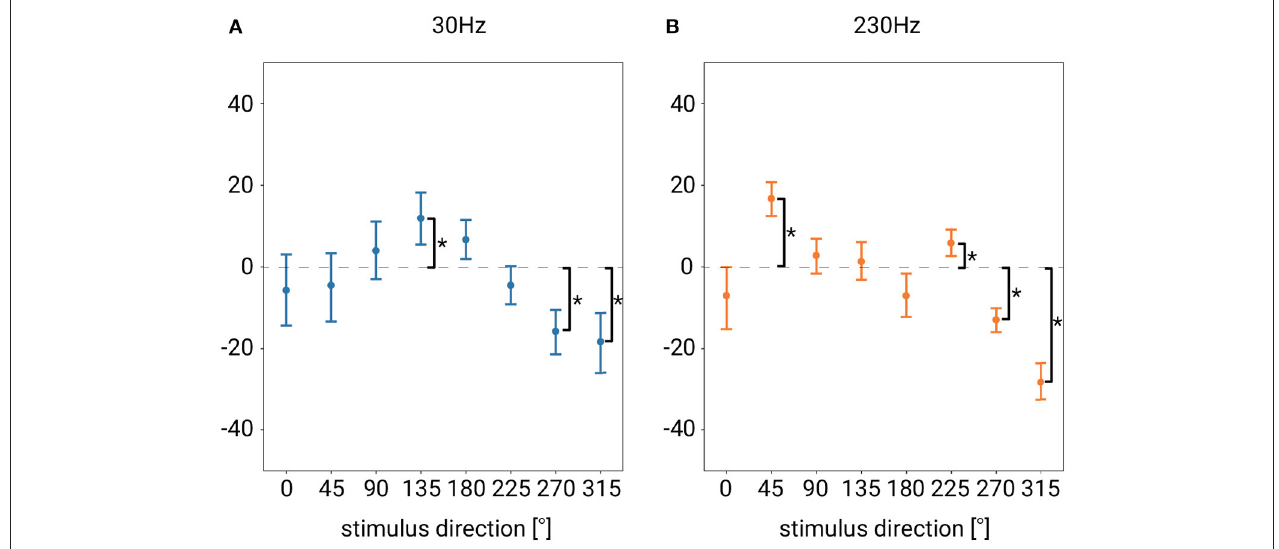
FIGURE 6 | Re-plot of Figure 5 , for each vibration frequency of the stimulus (A) Mean directional bias for stimulus direction at 30 Hz. (B) Mean directional bias for stimulus direction at 230 Hz. Error bars denote 95%CI. The asterisk indicates significant difference from 0.